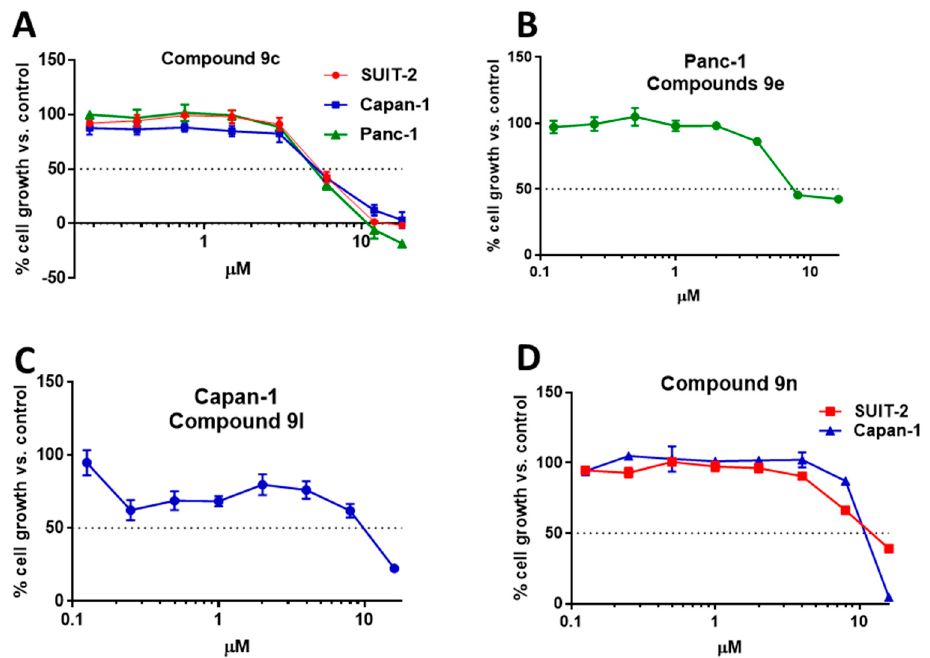
Figure 2. Representative growth inhibition curves of pancreatic ductal adenocarcinoma (PDAC) cells, SUIT-2 (red line), Capan-1 (blue line) and Panc-1 (green line) treated for 72 h with the compound 9c ( A ), 9e ( B ), 9l ( C ) and 9n ( D ). Points, mean values obtained from three independent experiments; bars, SEM.